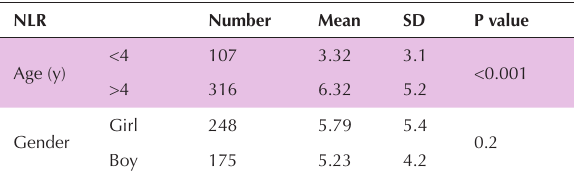
Table 1. Comparison of NLR means by age and gender in the present